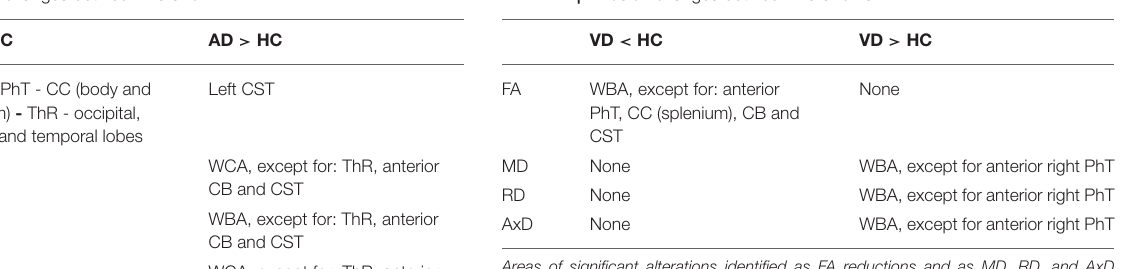
TABLE 3 | Diffusion changes between HC and AD. TABLE 4 | Diffusion changes between HC and VaD.